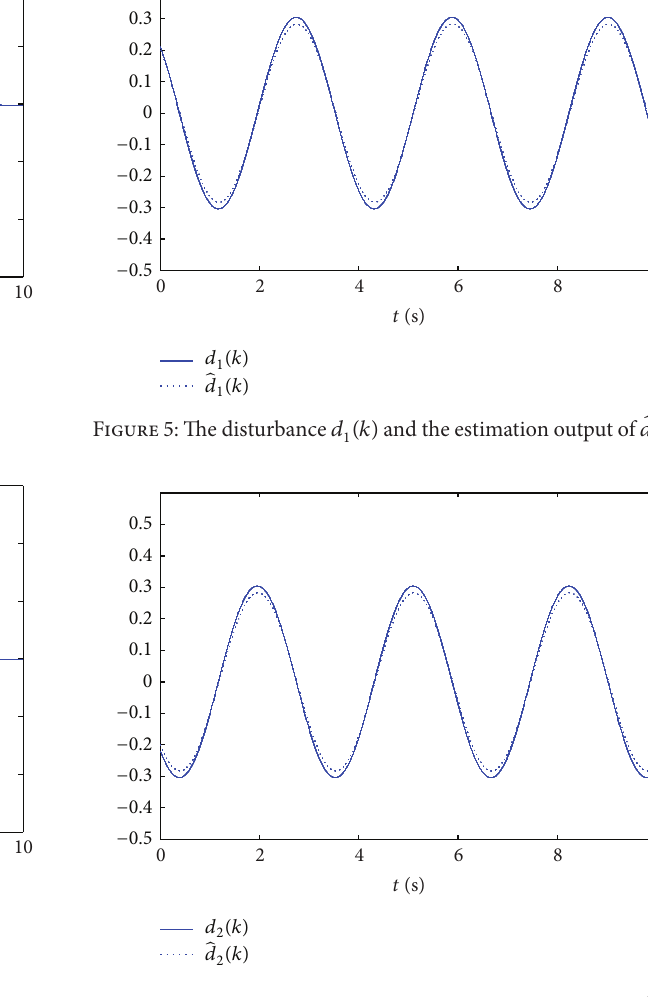
Figure 6: The disturbance 𝑑 2 (𝑘) and the estimation output of